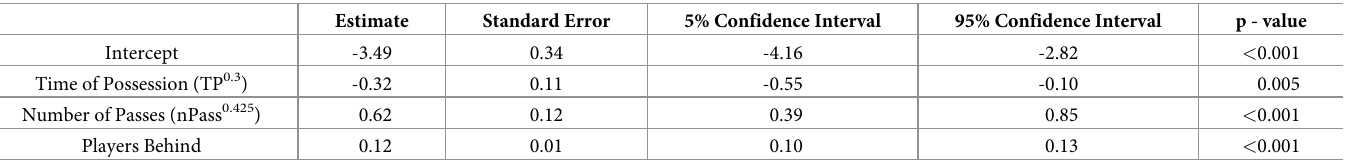
Table 5. Random effect estimated log odds intercepts and base probabilities for possessions that result in a return to the defensive zone for each team at the 2010, 2014 and 2018 World Cup